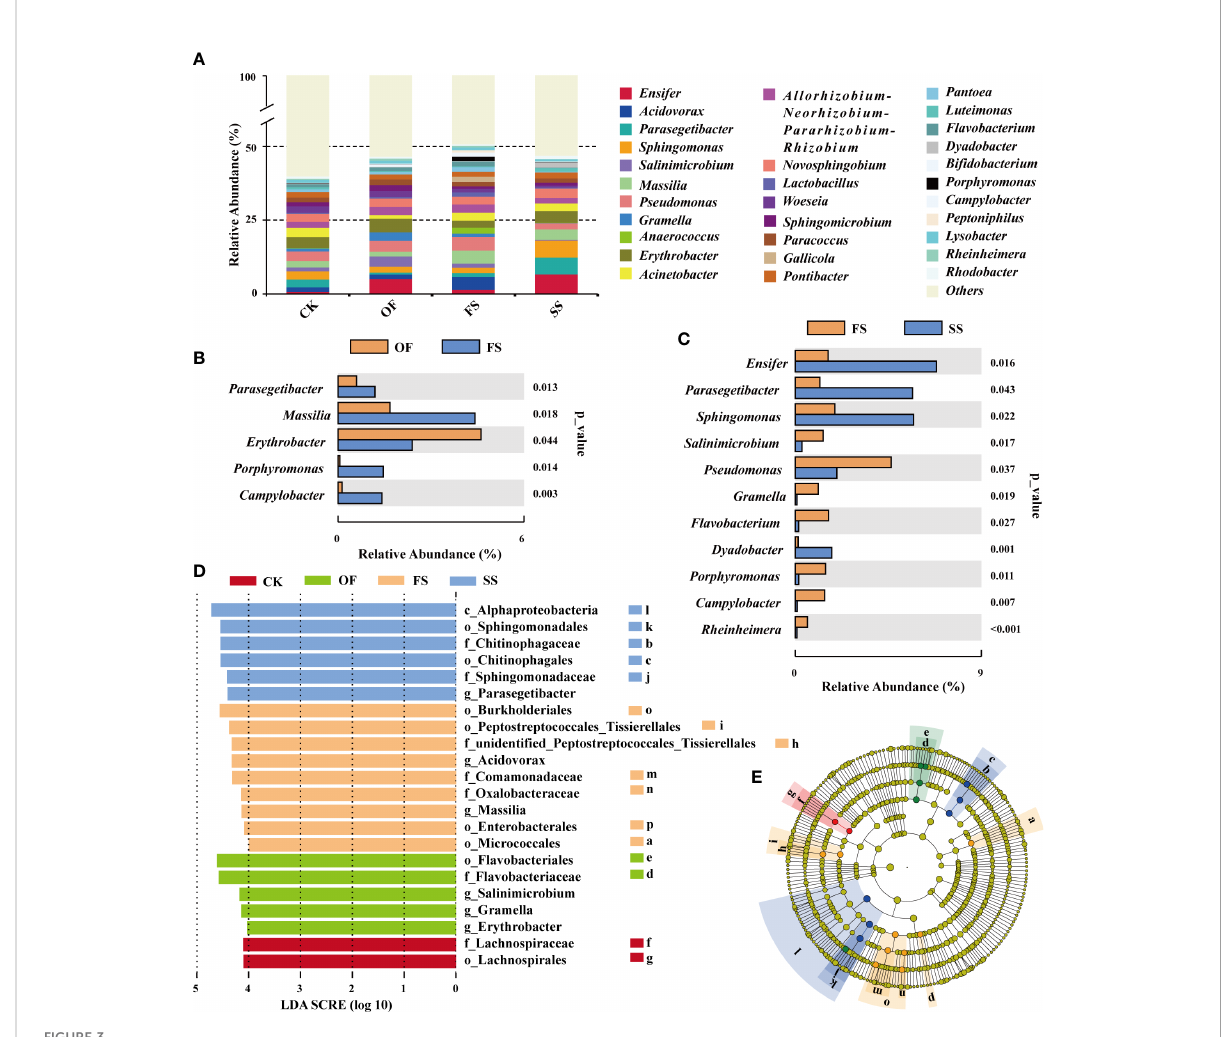
FIGURE 3 (A) Histogram of TOP-30 dominant bacterial community composition in genus level at different samples; (B, C) Analysis of the differences ( T - test) in the abundance of TOP-30 dominant genera in different samples (CK v . OF no signi fi cant difference genus; (B) OF v . FS; (C) FS v . SS); (D, E) LEfSe analysis indicates bacteria with dominant abundance in different samples at different taxonomic levels, (D) The distributed histogram of LDA value shows the bacteria with LDA score > 4, which namely biomarker (the pre fi xes o_, c_, f_, and g_ of bacterial name represent the order, class, family, and genus of different taxonomic levels of bacteria respectively); (E) Biomarker evolutionary cladistic diagram with statistically signi fi cant differences between different samples (the circle radiating from inside to outside represents the taxonomic level